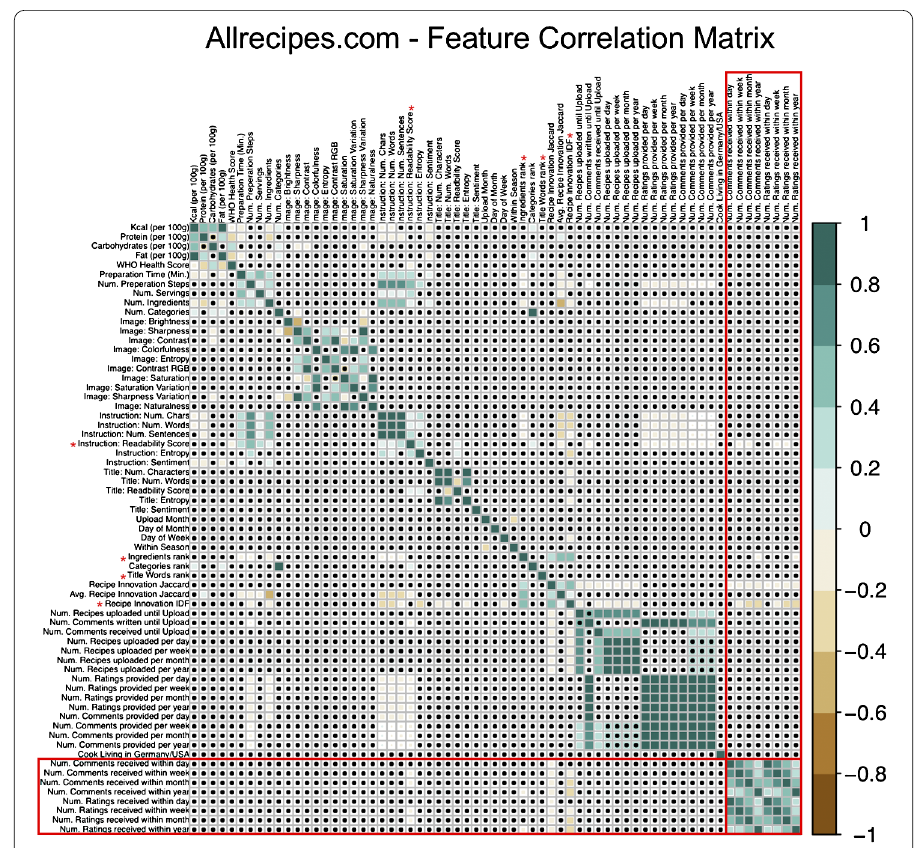
Figure 7 Feature correlation matrix (Spearman rank correlation) for the Allrecipe.com dataset (main dishes). Non-significant features ( p < 0.05) are marked with black dots. Features tested in the prediction experiment are highlighted via red boxes. Significant features are marked with a red asterisk ( ∗ ). The gradient color scale to the right ranges from –1 to +1 indicate Spearman rank correlations (–1 = –100%, 1 =